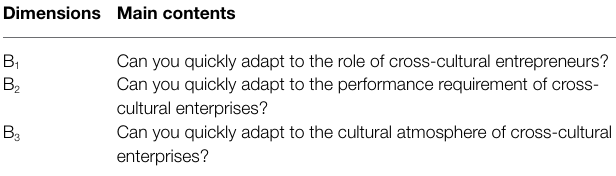
TABLE 2 | Cross-cultural adaptation measurement.